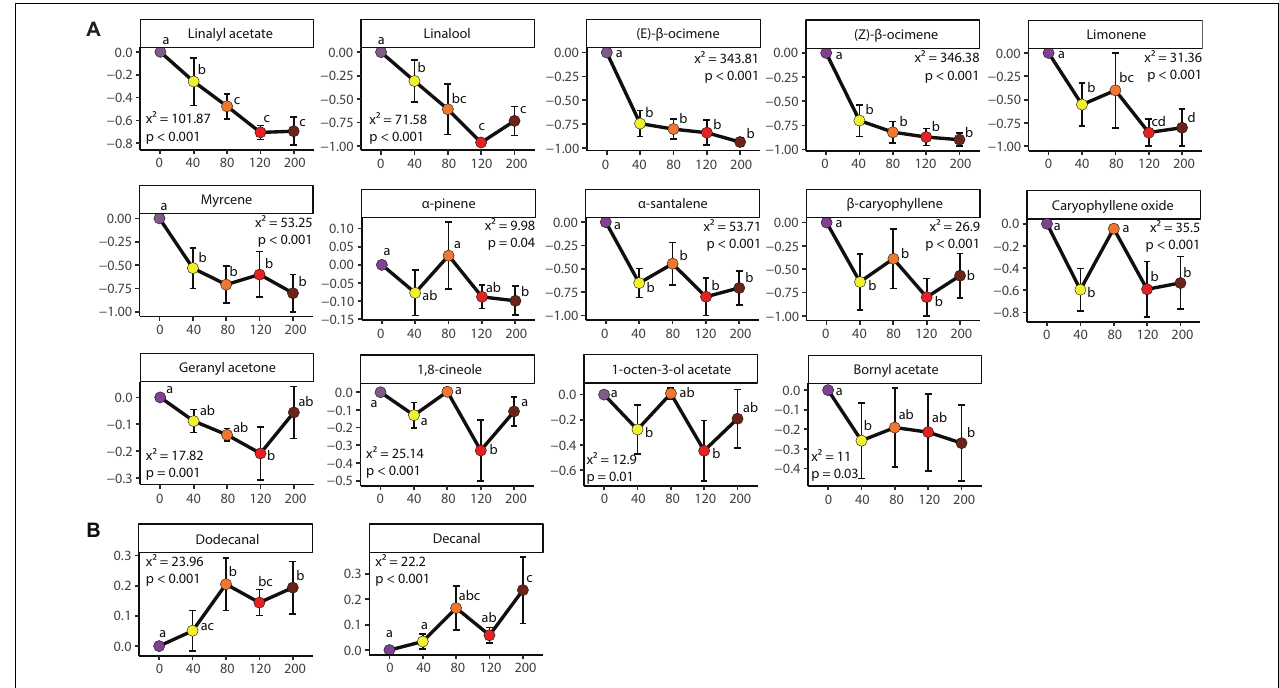
FIGURE 5 | Effects of exposure to increasing [O 3 ] in experiment 2 on the volatile organic compounds (VOCs) variation index (mean ± standard error). Panel (A) lists VOCs whose variation index significantly decreased with [O 3 ], (B) panel lists VOCs whose variation index increased significantly with increasing [O 3 ]. Purple, yellow, orange, red, and brown colors correspond, respectively to an [O 3 ] exposure of 0, 40, 80, 120, and 200 ppb. For each VOC, results of the linear models are presented and values of the variation index with different letters indicate statistically significant difference in pairwise comparisons ( p < 0.05).